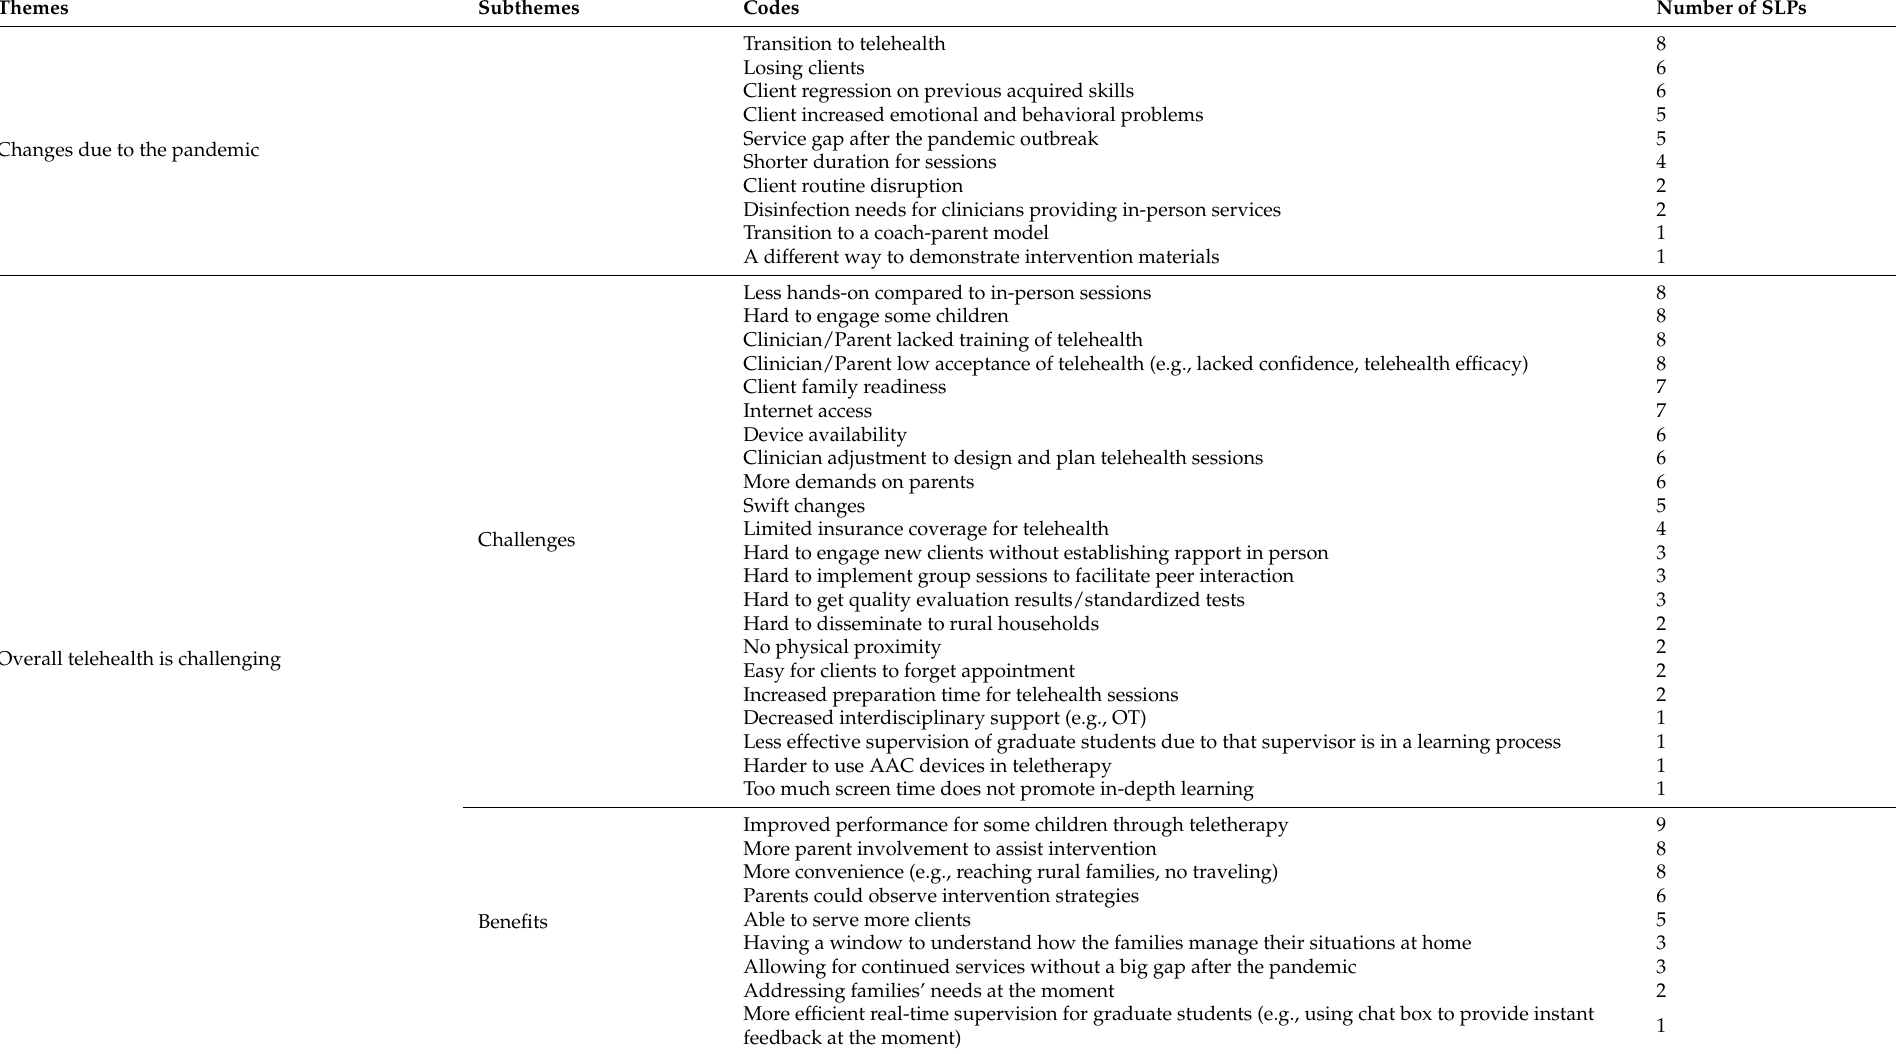
Table A1. Themes, subthemes, codes, and number of SLPs included each code when responding to the interview open-ended